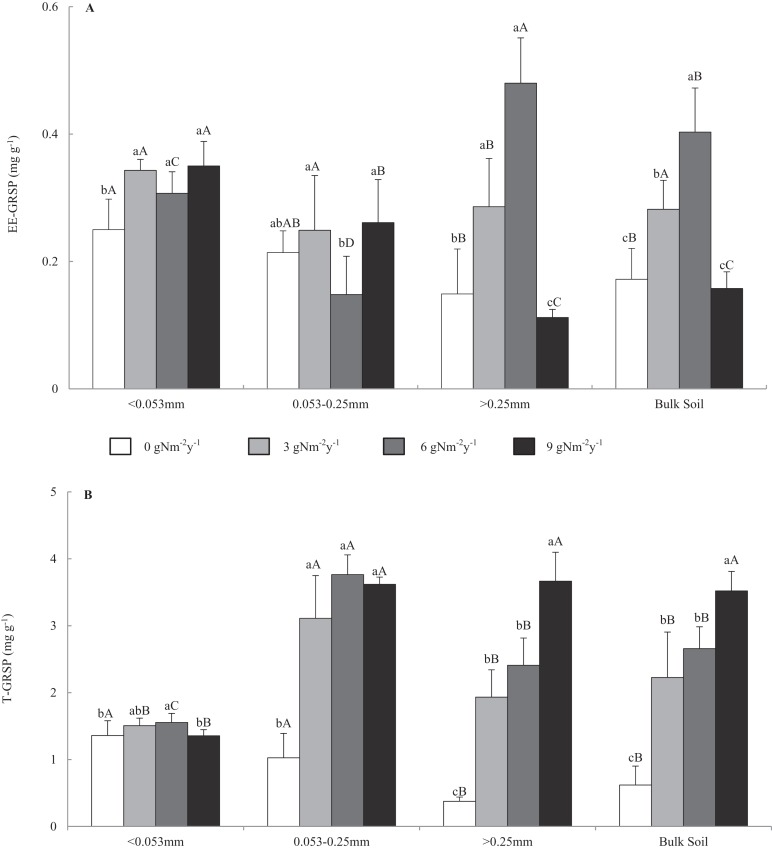
Distributions of easily extractable and total glomalin-related soil protein (A) EE-GRSP and (B) T-GRSP content in soil aggregates and bulk soil of different N addition treatments.Values followed by a different lowercase letters indicate significant difference among the N addition treatments, values followed by a different uppercase letters indicate significant difference among the aggregate size. P < 0.05, n = 6.